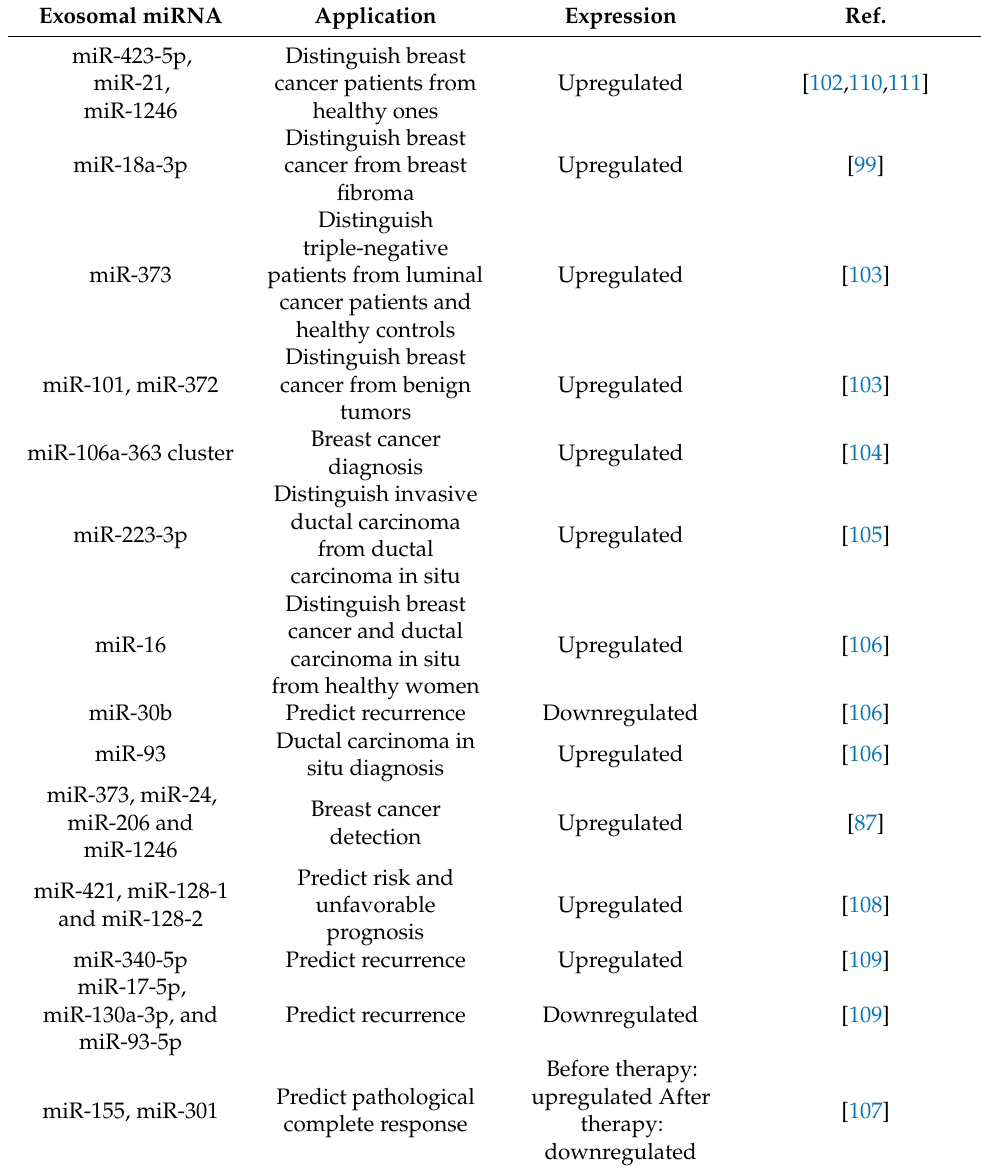
Table 2. Exosomal miRNAs involved in breast cancer